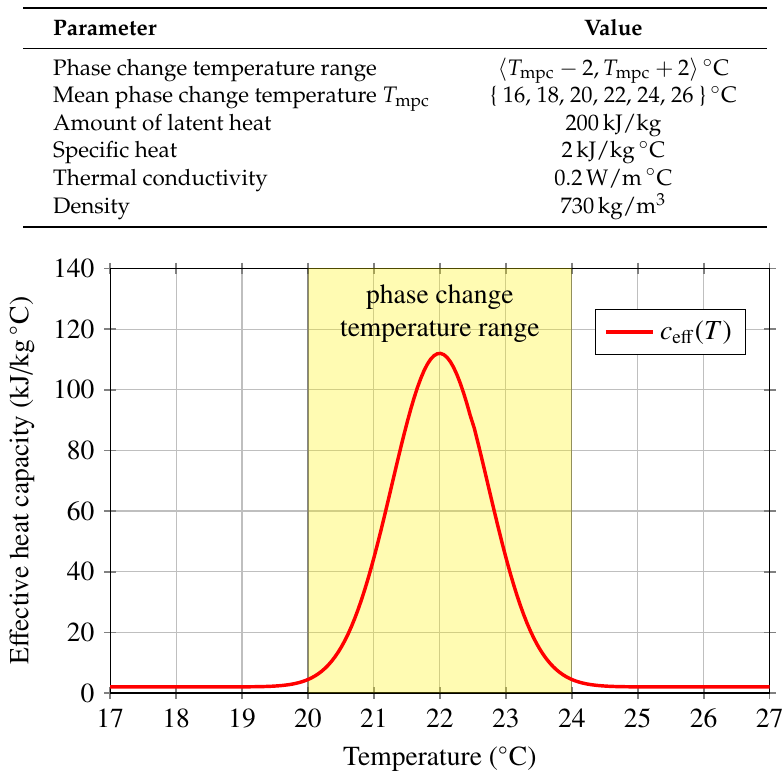
Figure 3. The curve of the effective heat capacity for the considered